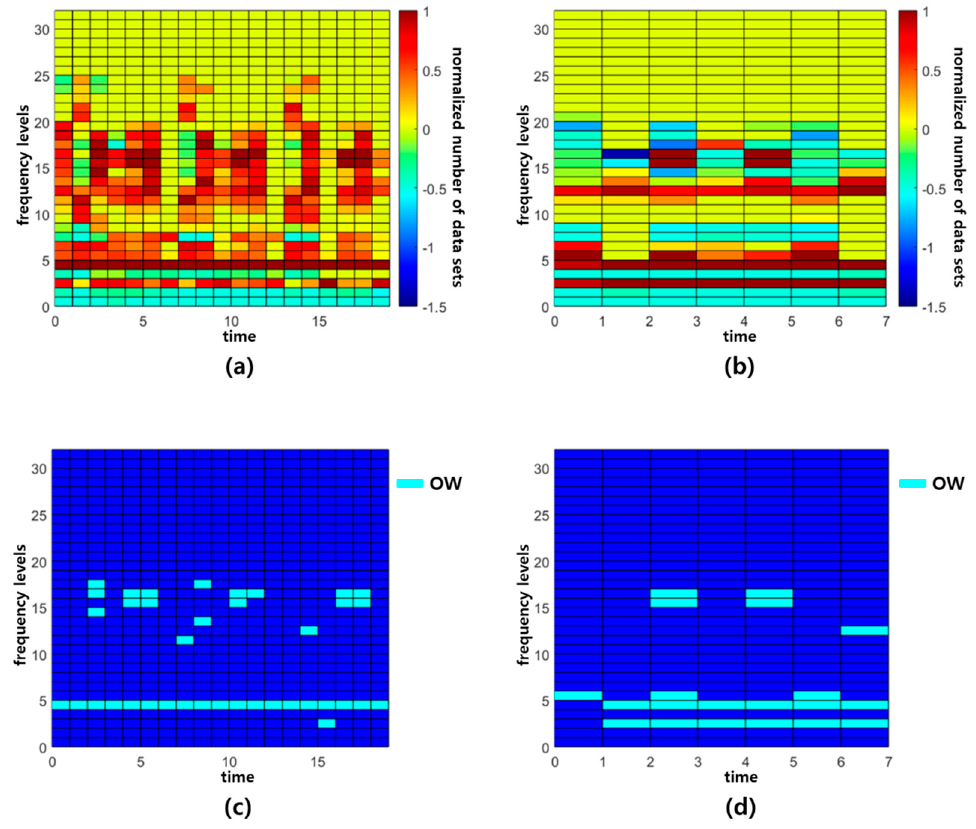
Figure 12. ( a ) CIM for N-R vs. A-R, ( b ) CIM for S-R vs. H-R, ( c ) selected outstanding windows (OWs) ( R c ≥ 0.95) in CIM for N-R vs. A-R, and ( d ) selected OWs ( R c ≥ 0.95) of CIM for S-R vs. H-R.